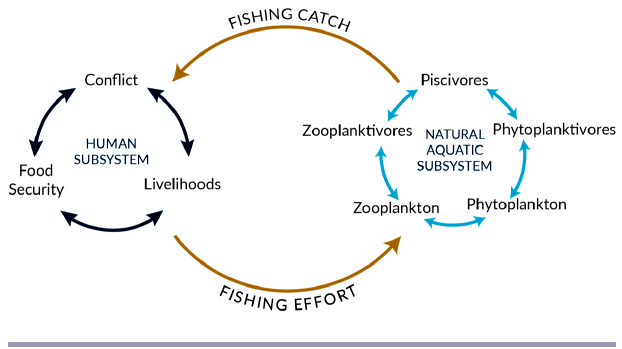
Fig. 3 . Our conceptual conflict-fisher system is comprised of couplings between the human subsystem containing conflict and a natural aquatic subsystem containing fish populations. Fishing effort and fish catch play critical roles: both variables independently assimilate the influences of multiple variables originating within their respective subsystems while linking one subsystem to the